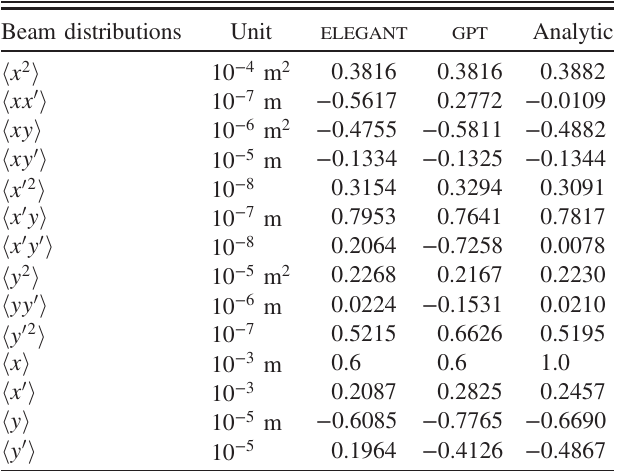
all the elements of the beam matrix is listed in Table